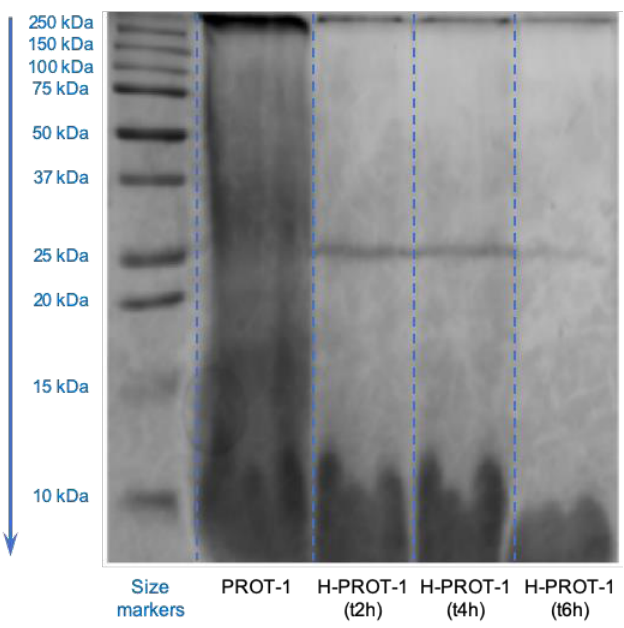
Figure 3. SDS-PAGE analysis of the PROT-1 fraction followed during enzymatic hydrolysis catalyzed by the protease preparation Flavourzyme ® .